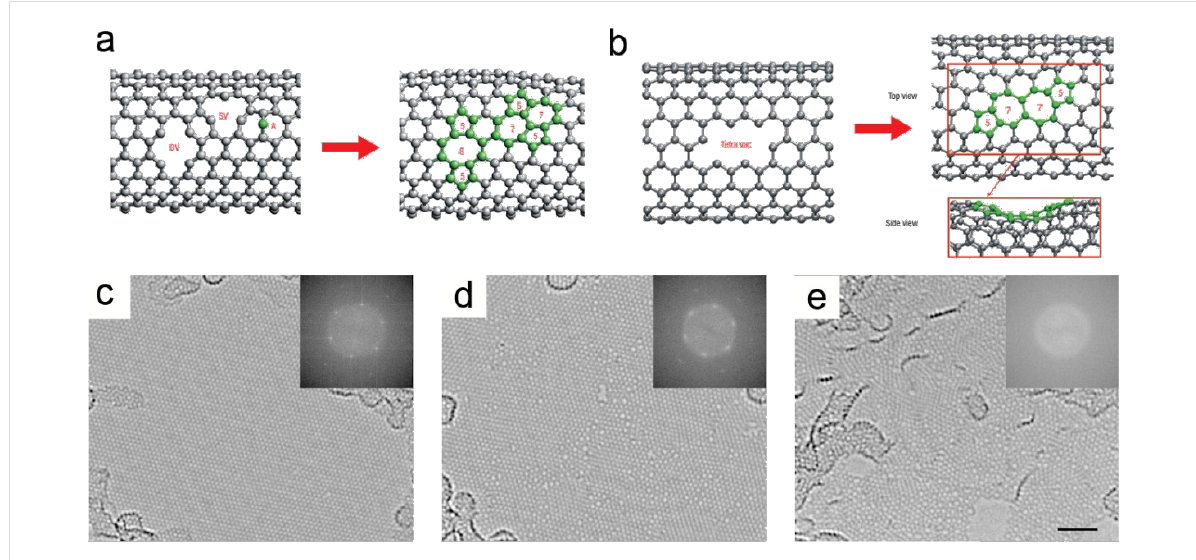
Figure 4: (a–b) Reconstruction of the atomic network of a CNT near vacancies and adatoms is predicted by atomistic computer simulations. SV, DV, tetravacancies and adatoms may transform into a Stone–Wales (5–7–7–5) defect and 5-8-5 defects; reproduced with permission from [43], Copyright (2007) Nature Publishing Group. (c–e) Amorphization of graphene demonstrated by three TEM images and their corresponding Fourier transforma- tions (insets) at (c) a low irradiation dose (1.25 × 10 8 e − /nm 2 ), (d) an intermediate dose (2.94 × 10 9 e − /nm 2 ) and (e) a high dose (9.36 × 10 9 e − /nm 2 ); reproduced with permission from [36], Copyright (2014) Nature Publishing